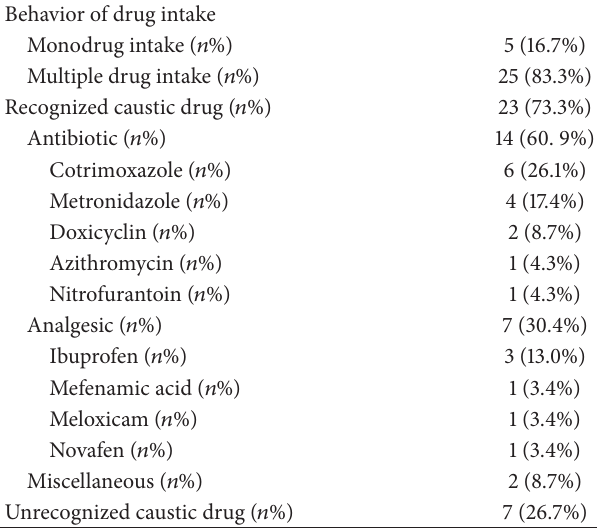
Table 1: Demographic data and clinical features of patients with generalized fixed drug eruption.